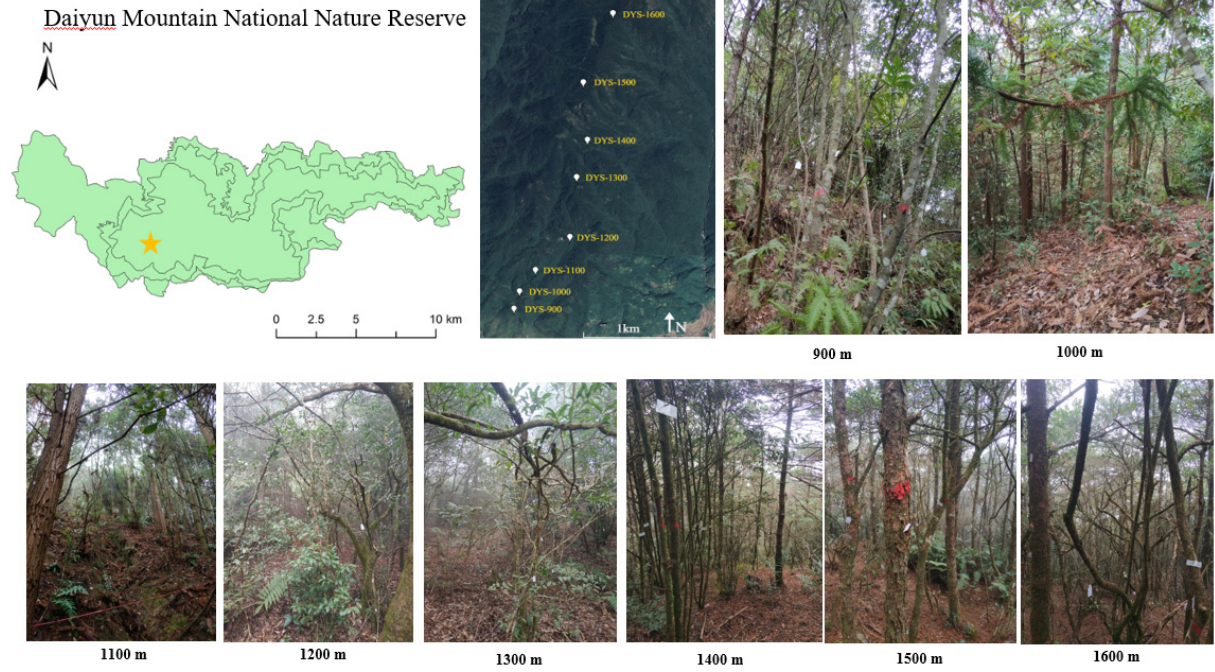
Figure 1. General information of sample plots along elevations in Daiyun